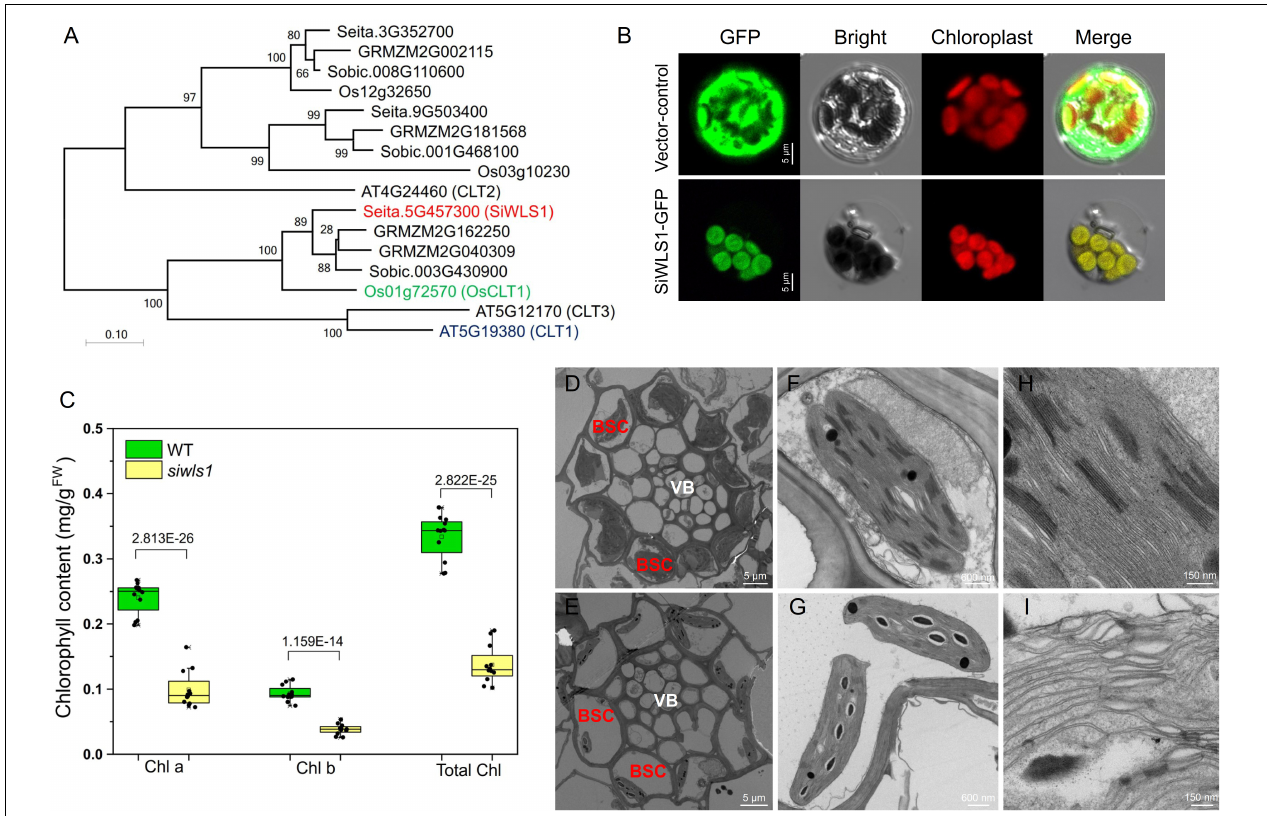
FIGURE 6 | Functional analysis of foxtail millet white leaf sheath gene SiWLS1 . (A) Phylogenetic relationship between SiWLS1 and its homologs in maize, sorghum, rice, and Arabidopsis. (B) Subcellular localization of SiWLS1 protein. (C) Comparison of chlorophyll contents between siwls1 mutant and wild-type plants. (D–I) Chloroplast ultrastructure in siwls1 mutant (the lower row) and wild-type (the upper row) plants. VB, vascular bundle; BSC, bundle sheath